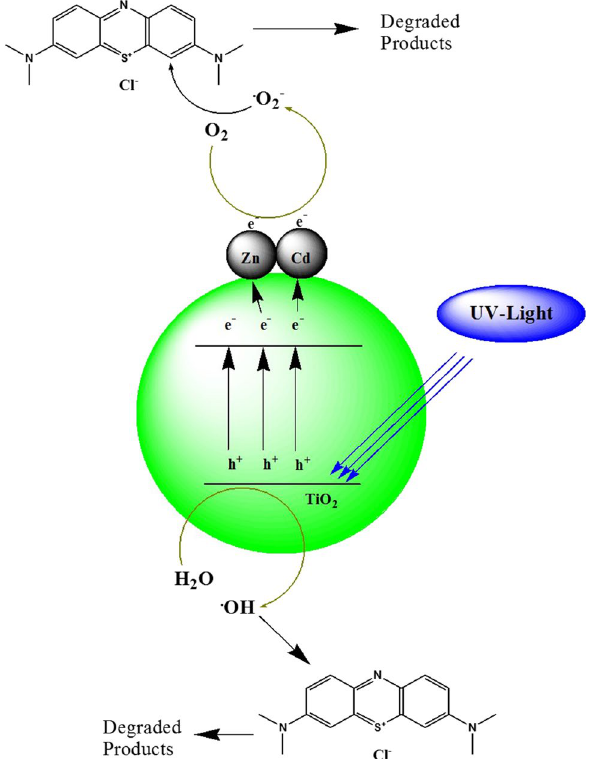
Fig. 11 Proposed mechanism for the photodegradation of MB dye